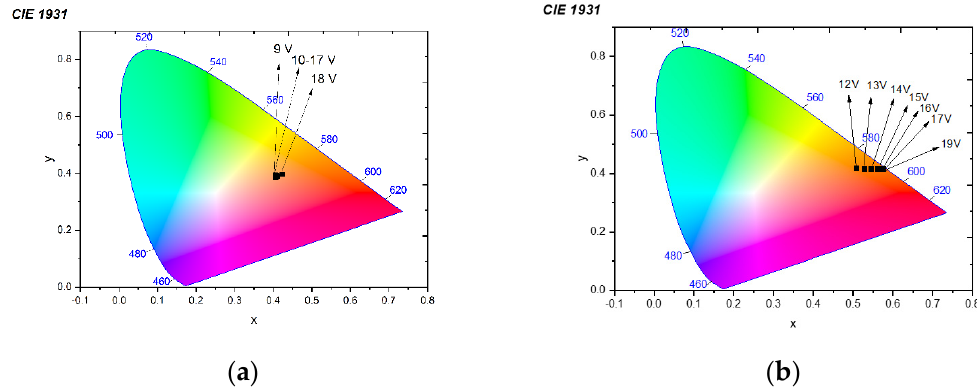
Figure 7. Electroluminescence versus applied voltage for the ( a ) electrospun cathode devices; ( b ) thin